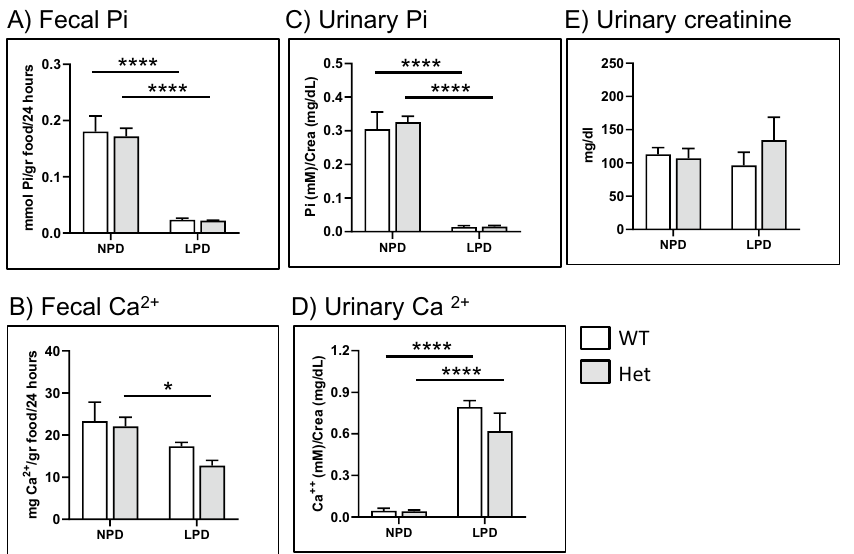
Figure 2. ( A ) Fecal Pi, ( B ) fecal Ca 2+ , ( C ) urinary Pi, ( D ) urinary Ca 2+ and ( E ) urinary creatinine of wild type (n = 4) and heterozygous (n = 5) Slc34a2 rats fed standard chow (NPD) or challenged for 3 days with low Pi diet (LPD). Data are presented as means ± SEM. Statistical significance was calculated by ANOVA-Bonferroni. * P ≤ 0.05 and **** P ≤